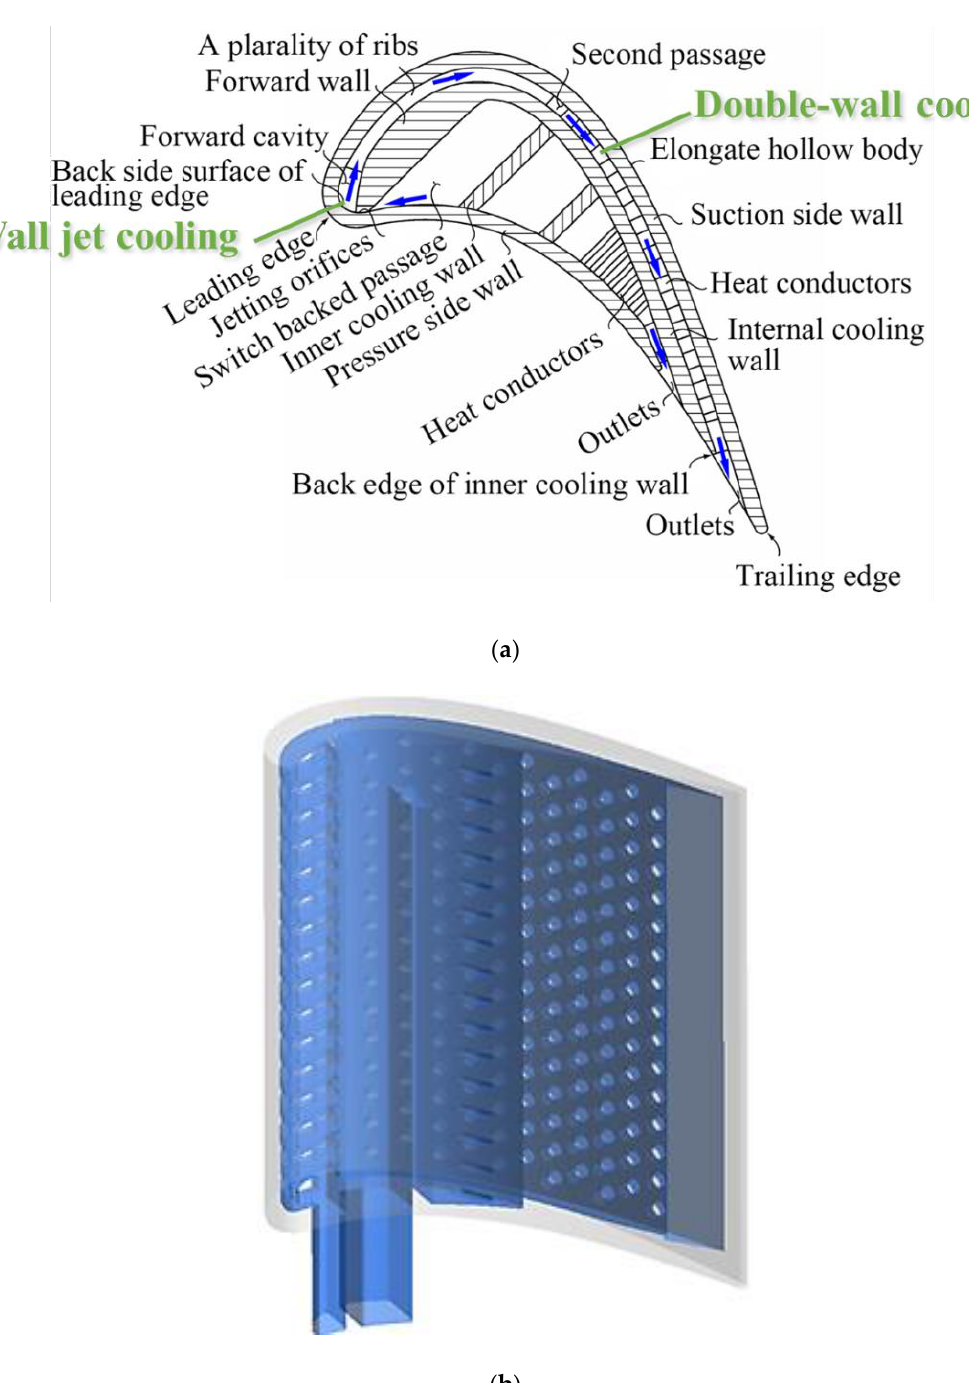
Figure 1. The multi-channel wall cooling structure. ( a ) Section view [30]; ( b ) Overall structure.